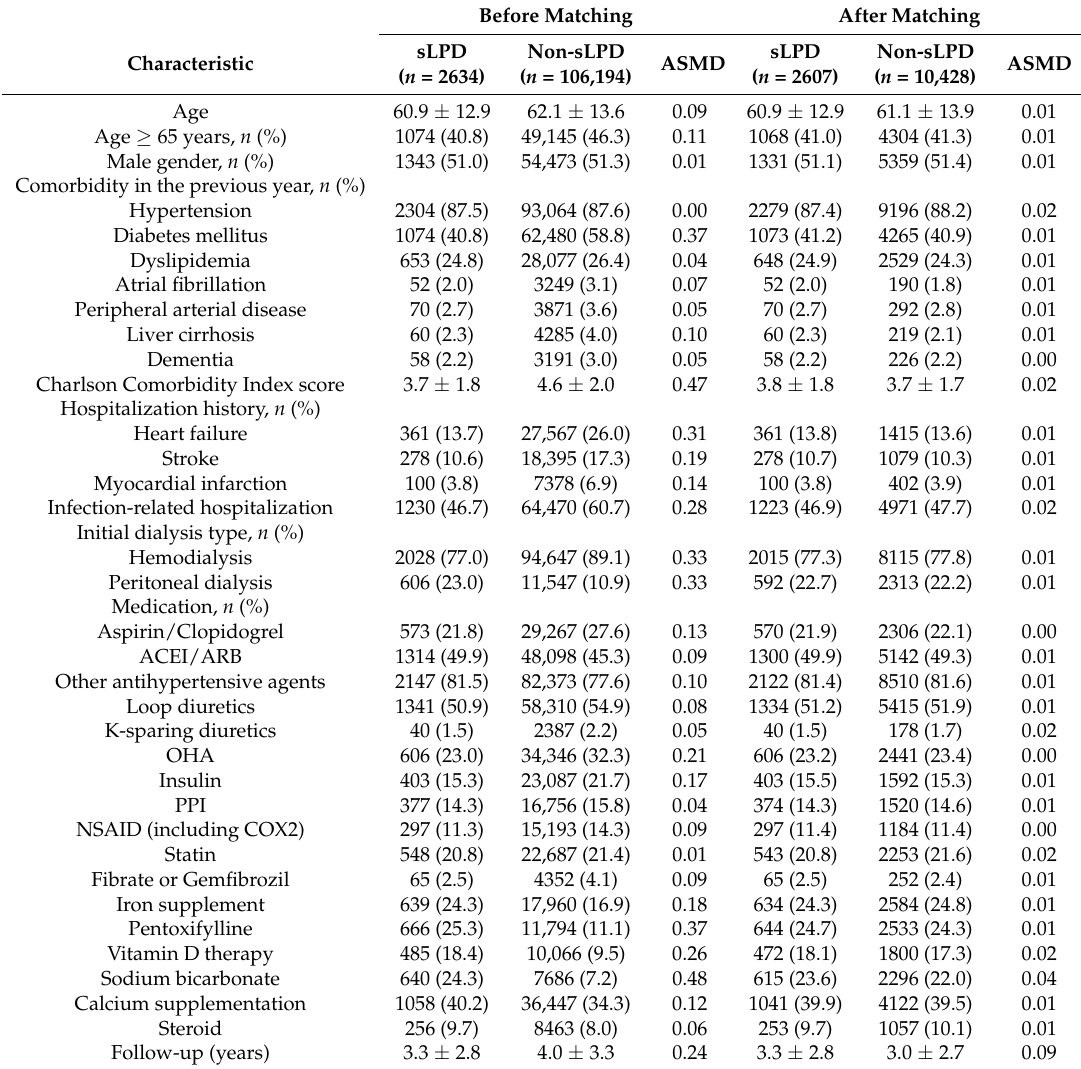
Table 1. Characteristics of the all study